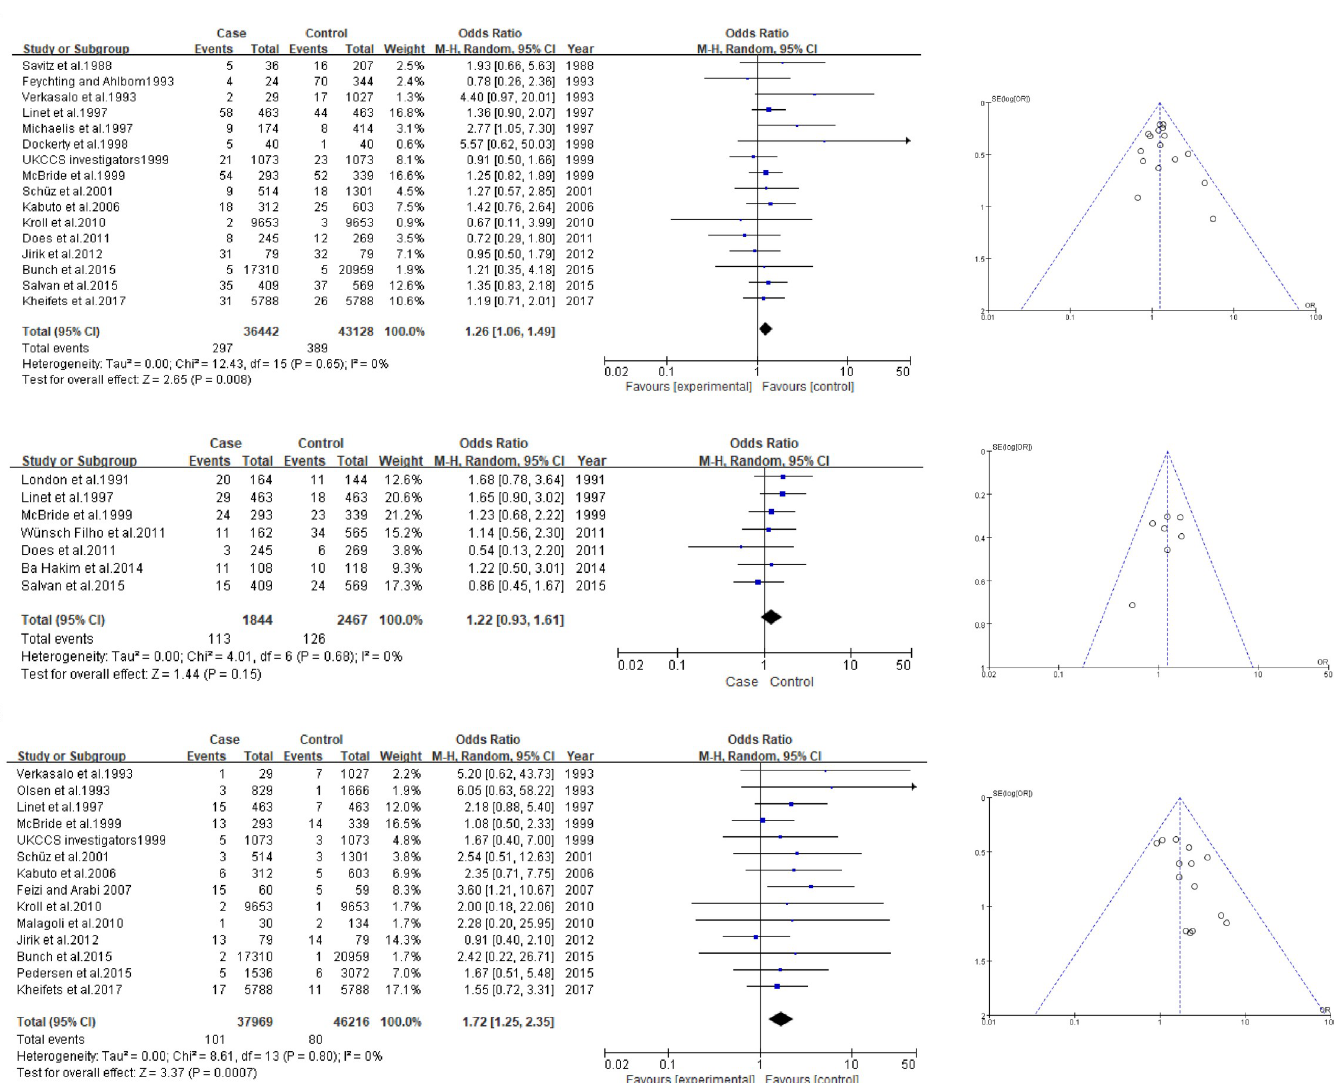
Fig 2. Forest plot and funnel plot of exposure to ELF-MFs and risk of childhood leukemia. The pooled odds ratio of childhood leukemia by each exposure level of ELF-MFs: A 0.2- μ T exposure level; B 0.3- μ T exposure level; C 0.4- μ T exposure level.